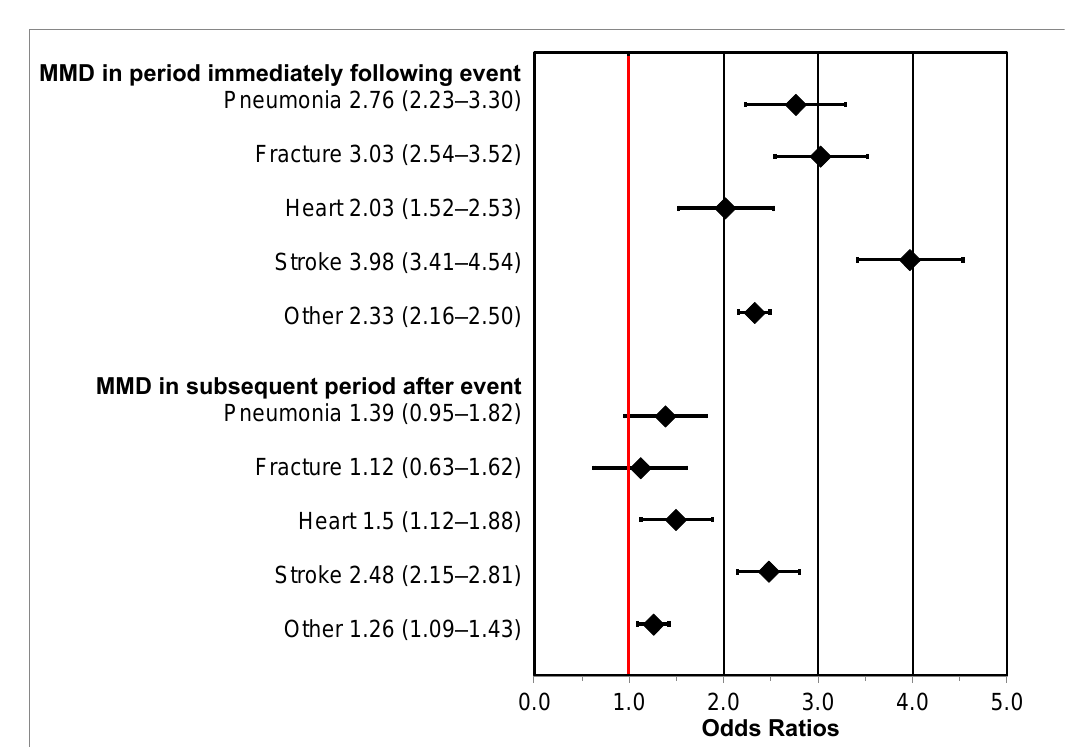
Figure 1. Adjusted odds ratios (OR) and 95% confidence intervals (95% CI) for the association between intervening hospitalization events and major mobility disability (MMD) in the assessment period immediately following hospitalization (“short-term” MMD; 1 day to 6 months after hospitalization) and the subsequent assessment period (“long-term” MMD; 6–12 months after hospitalization). The reference group is those without hospitalization and the “Other” group consists of hospitalizations of any cause. The red vertical line represents the null value.